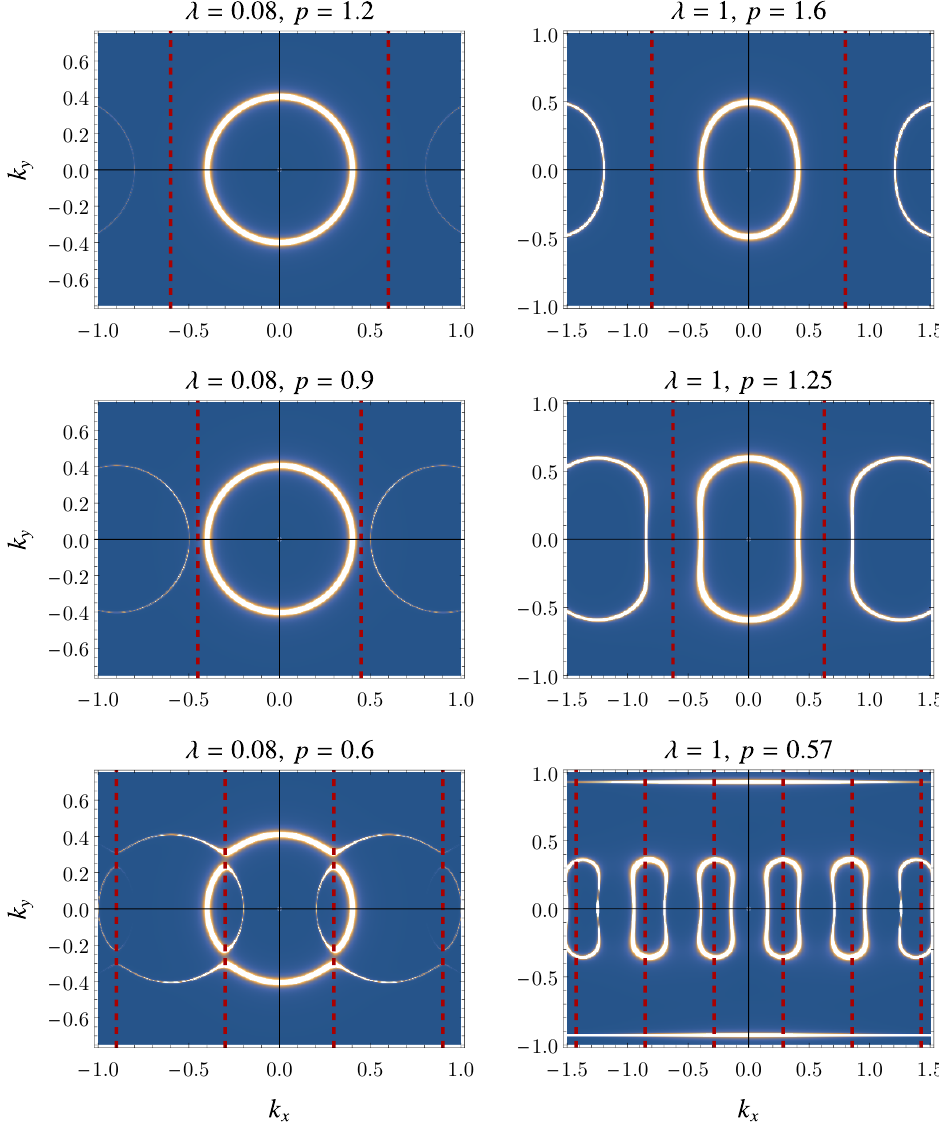
Figure 1 . The shape of the Fermi surface of a non-interacting 2+1 dimensional Dirac toy model in a unidirectional periodic chemical potential. Shown is the spectral density (2.7), which equals the 00 component of the inverse matrix M (2.6). Left column: at weak modulation amplitude (cid:21) = 0 : 08, the shape of the Fermi surface appears circular as in the absence of a lattice. However, lattice copies appear in the neighboring Brillouin zones (BZ). When the BZ (red dashed gridlines) becomes smaller than the Fermi momentum, these copies overlap and an Umklapp gap is opened at the intersection point, giving rise to Fermi pockets. Right column: at strong modulation amplitude (cid:21) = 1 nonlinear e(cid:11)ects are seen. The shape of the Fermi surface is now a(cid:11)ected even far from the boundary of the BZ. When BZ gets smaller, the FS is (cid:12)rst squeezed and then strong Umklapp gaps are opened, leading to the small dumbbell-like Fermi pockets near k x axis and the nearly k x independent (cid:13)at \band" at (cid:12)nite k y .